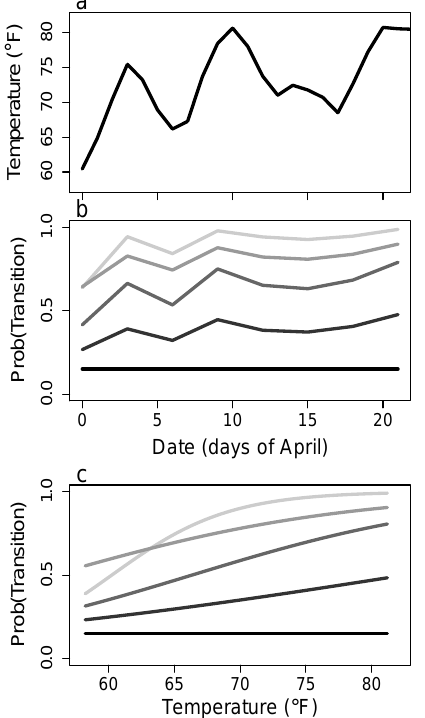
Figure 4. Change in ( a ) mean air temperature and ( b ) the probability of growing during a 3-day interval for A. aidea over the study period. The change in growth probabilities over time ( b ); is due to the relationship between transition probabilities and temperature ( c ). Temperature represents the hourly regional air temperature averaged over each 3-day time step. From light to dark, the lines in ( b , c ) represent early to late